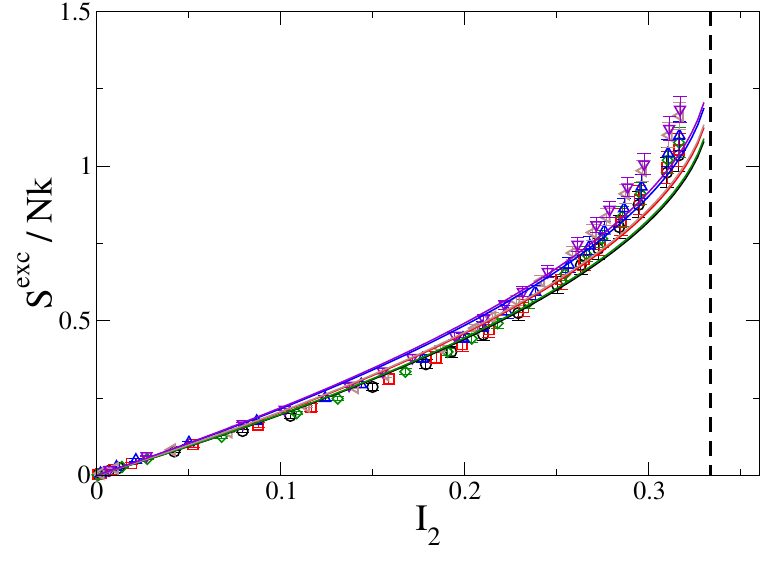
Figure 5. (Color online) Dimensionless excess orientational entropy per particle, S exc /Nk for the Gay–Berne model of [30] as a function of the second tensorial invariant of Q . The same color coding as in Figure 4 is